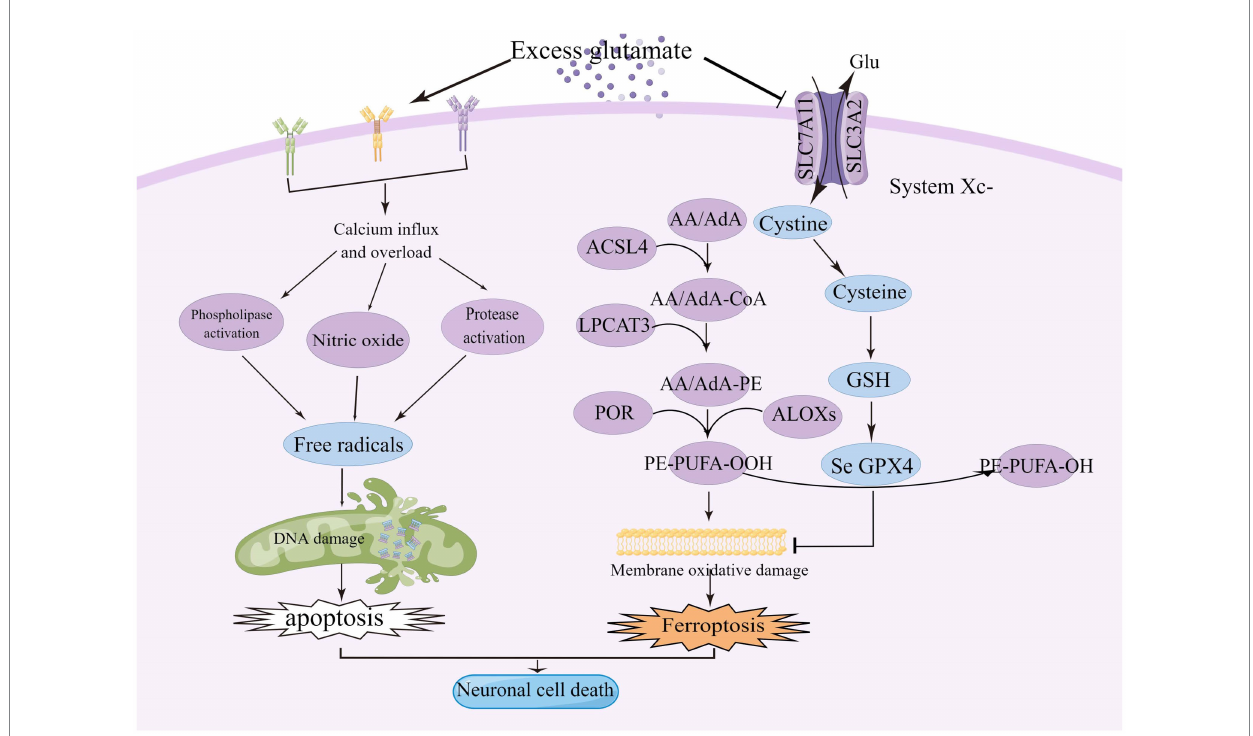
FIGURE 1 Excitotoxicity is caused by over-stimulation of glutamate receptors, particularly NMDAR, leading to high calcium influx, mitochondrial dysfunction, and DNA breakage. High levels of glutamate reduce the uptake of cystine via the Xc-system, leading to intracellular glutathione depletion resulting in the accumulation of reactive oxygen species (ROS), which increases lipid peroxidation, mitochondrial damage and ultimately ferroptosis. ACSL4, acyl- coenzyme A synthase long chain family member 4; System Xc-, cystine/glutamate reverse transporter; LPCAT3, lysophosphatidylcholine acyltransferase 3; AA, arachidonic acid; AdA, adrenoyl acid; ALOXs, lipoxygenases; CoA, coenzyme A; POR, cytochrome p450 oxidoreductase; GPX4, glutathione peroxidase 4; and GSH,